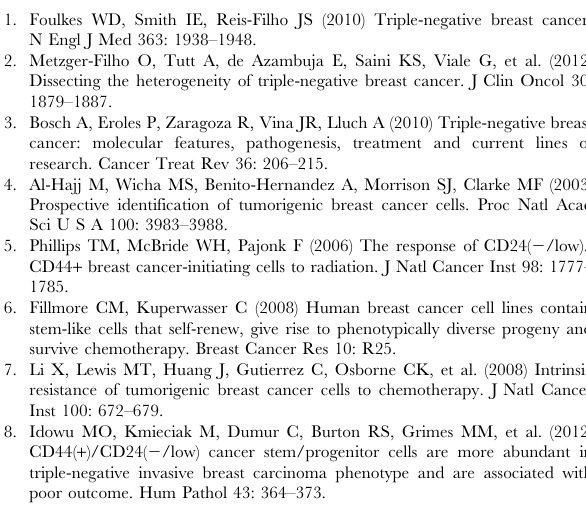
Figure S1 Inhibition of sphere forming efficiency and sphere size by CDDO-Im in SUM149 and MCF10DCIS.- com cells. SUM149 (A) and MCF10DCIS.com (B) human breast cancer cells were treated with vehicle control or CDDO-Im (100 nM) for 7 days in sphere culture. Representative micropho- tographs of tumorspheres after 7-day incubation were shown. Two independent experiments in triplicate were conducted. Averages of the sphere forming efficiency with or without CDDO-Im treatment are shown in the graph (**p , 0.01). The size of tumorspheres was divided into three ranges (50 , 100, 100 , 200 and . 200 m m). Average number of tumorspheres in each size range is shown in the graph. Table S1 List of 84 stem cell signaling genes in SUM159 tumorspheres and their changes by CDDO-Im. SUM159